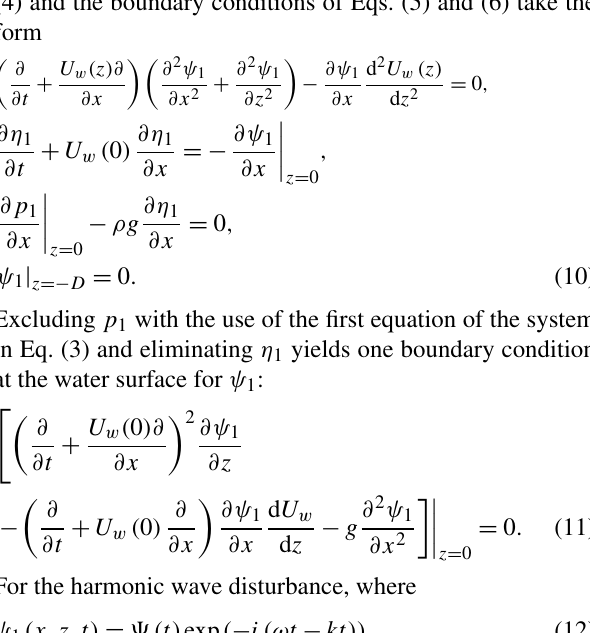
Figure 7. The measured phase velocity C S versus theoretical pre- diction: (a) linear model and (b) nonlinear